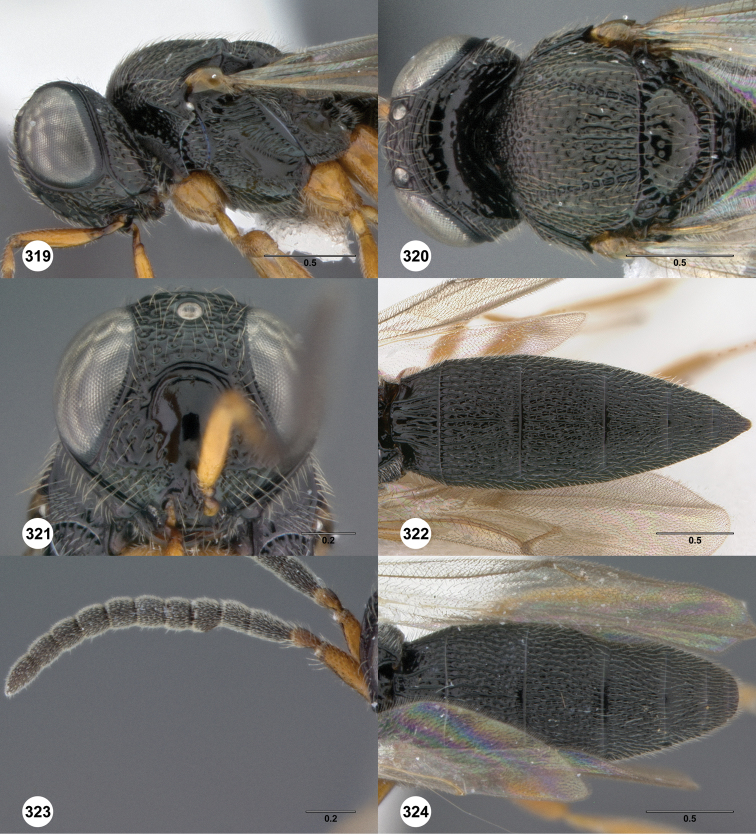
Oxyscelio sepisessor sp. n., holotype female (OSUC 438936) 319 Head and mesosoma, lateral view 320 Head and mesosoma, dorsal view 321 Metasoma, dorsal view. Paratype female (OSUC 227542) 322 Head, anterior view. Paratype male (OSUC 438946) 323 Antenna 324 Metasoma, dorsal view. Morphbank88